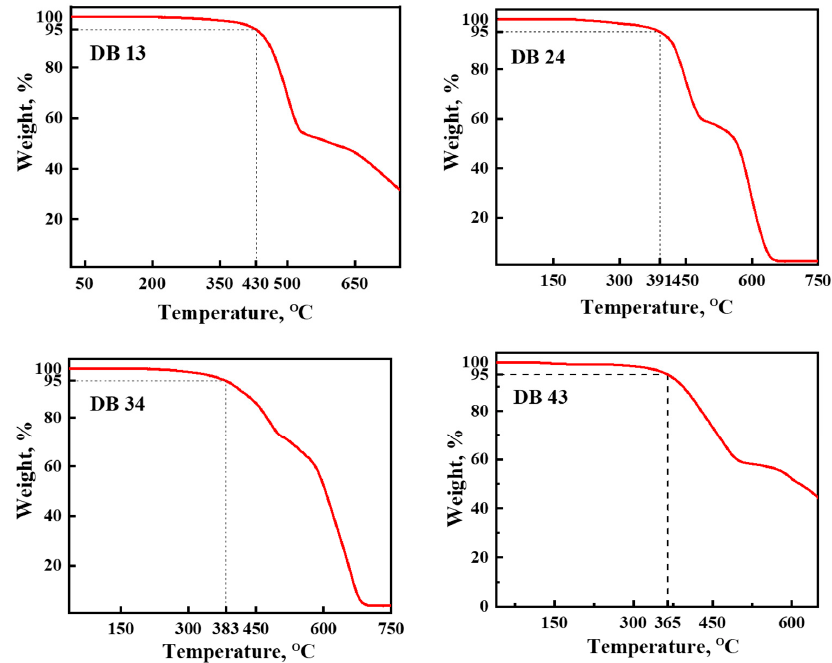
Figure 9. Data of thermogravimetric analysis (TGA) of the compounds DB13, DB24, DB34 and DB43.